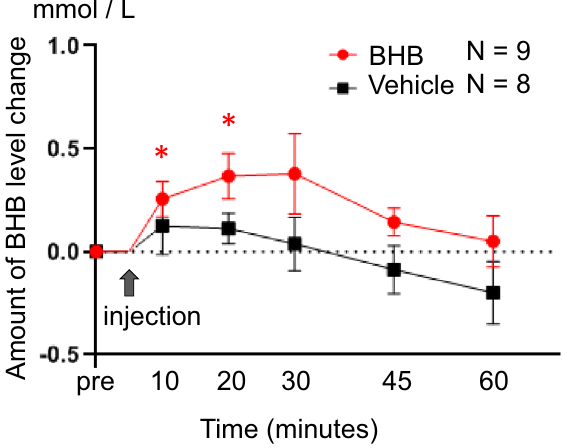
Figure 1. Elevated levels of blood BHB after subcutaneous administration of BHB. Levels of blood BHB were measured after subcutaneous injection of BHB. BHB concentration significantly increased 10–20 min after injection compared to the one before BHB injection (paired t-test; 10 min: t = − 3.00, df = 8, p = 0.017, 20 min: t = − 3.32, df = 8, p = 0.011), and gradually decreased thereafter. BHB concentration did not significantly increase after PBS injection. The degree of change in BHB was calculated as follows: (the level of BHB at each time point)—(the level of pre-injection BHB). Data are shown using mean value and standard error. Paired t-test was performed to compare blood BHB level at pre-injection and at each time point. n = 9/BHB injection group and n = 8/Vehicle injection group. BHB: beta-hydroxybutyrate, * p <